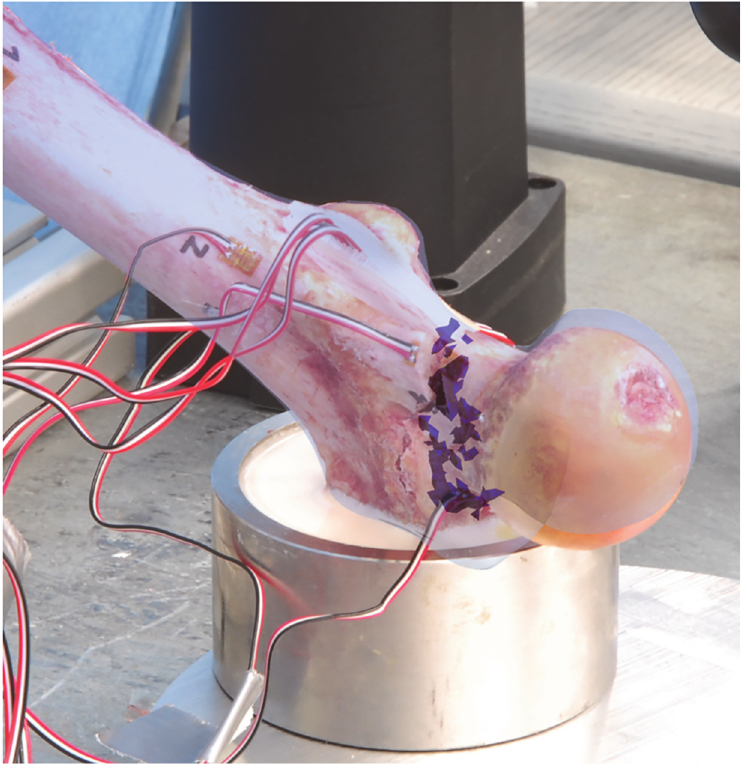
Fig 5. Image overlay of the macroscopic aspect of the fractured bone after destructive testing and the failed elements derived from the FE model (right). Failed elements derived from the FEA model are marked in purple, the change in shape (dislocation after destructive testing) is illustrated as blue shadow. doi:10.1371/journal.pone.0116907.g005 subjects without history of vertebral fragility fracture (p = 0.028). According BMD measure- ments from the femoral head and neck of these 8 subjects were compared to the calculated risk factor values as outline in Table 3. Unlike the risk factor assessment from the FEA model, BMD measurements of the hip did not show significant differences (femoral head: p = 0.989; femoral neck: p = 0.366) between the subjects depending on vertebral fracture status.